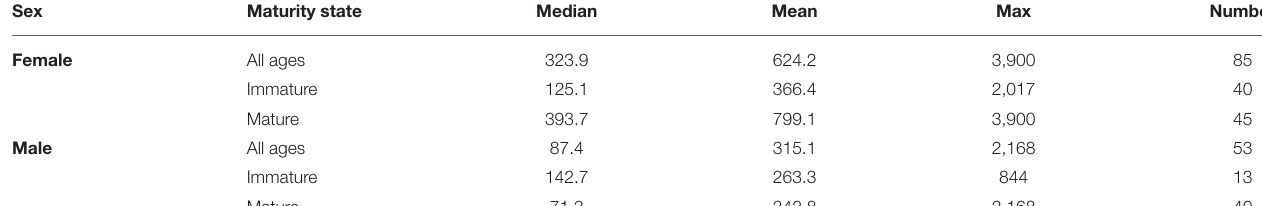
TABLE 1 | Summary of distance traveled by tope of each sex and maturity state from all tagging data showing median, mean, and maximum distance traveled in kilometers as well as number of records. Sex Maturity state Median Mean Number